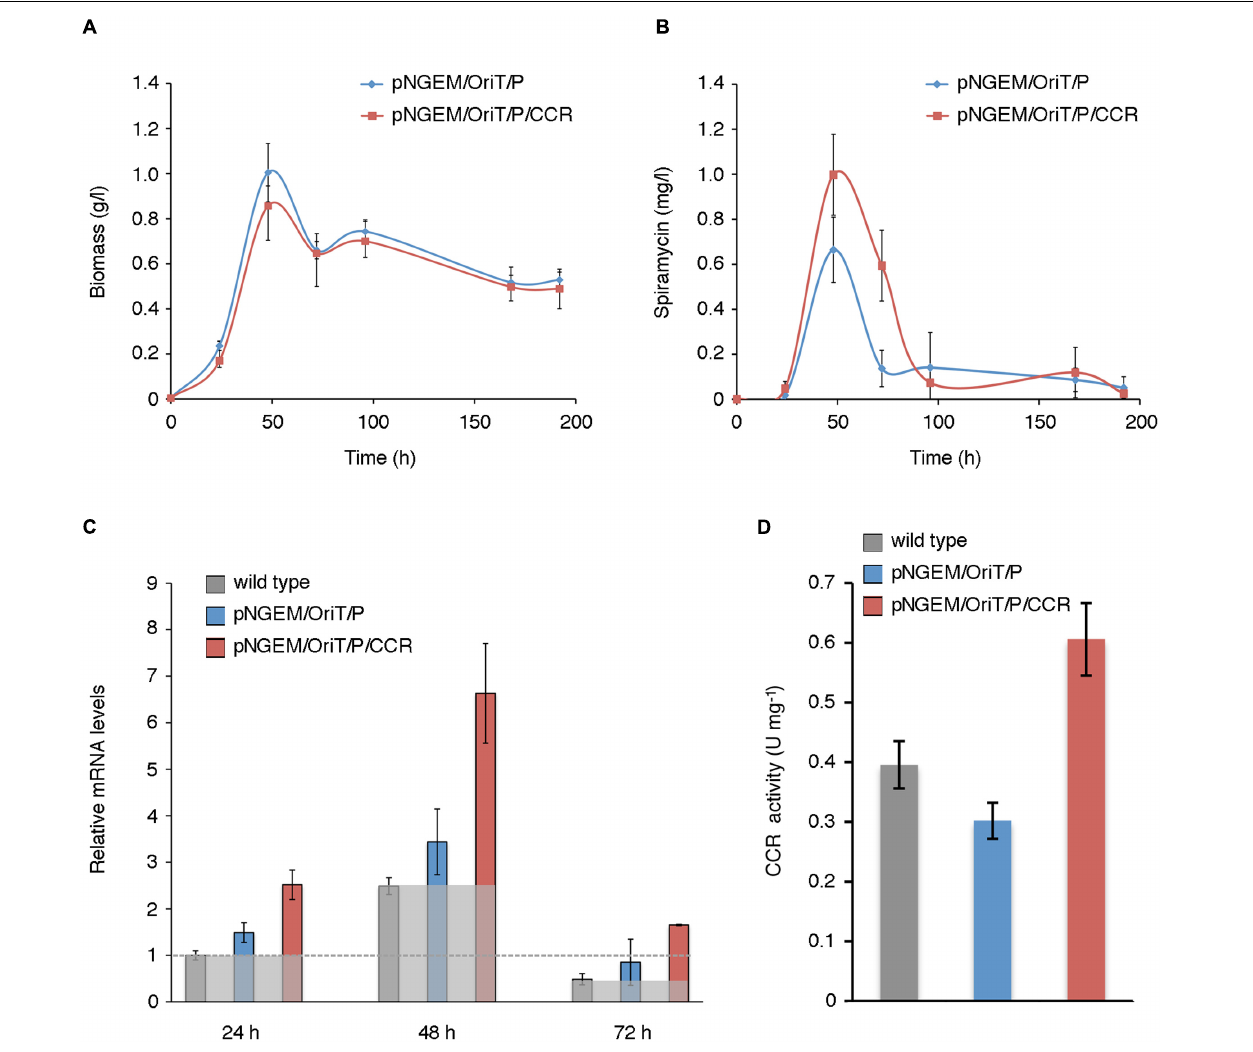
FIGURE 5 | Genetic manipulation of the ethylmalonyl-CoA metabolic node. (A,B) Mycelial growth (A) , and spiramycin production (B) of wild type and trans-conjugant strains harboring pNGEM/OriT/P/CCR or control plasmid pNGEM/OriT/P grown in YS medium. Values represent mean ± standard deviation (SD) (bars) from seven independent experiments (biological replicates). In (B) , each assay was carried out with triplicate samples (technical replicates). The variability associated with the technical replicates (including extraction and analytic procedure with samples processed the same day) was less than 0.3%. (C,D) ccr ( srm4 ) mRNA levels (C) and CCR enzymatic activity (D) in wild type and recombinant strains. In (C) , the expression levels of ccr ( srm4 ) (means from three independent experiments), compared with those of the wild type strain at 24 h arbitrarily assumed equal to 1, are reported. Bars represent standard deviations. The sheer gray boxes delineate the expression levels of ccr ( srm4 ) in the wild type strain for each time point; the gray dotted line marks the expression levels of ccr ( srm4 ) of the wild type strain at 24 h taken as calibrator for the histogram representation. In (D) the CCR enzymatic activity was determined in crude mycelial extracts of wild type and trans -conjugant strains harboring pNGEM/OriT/P/CCR or control plasmid pNGEM/OriT/P grown in YS medium for 48 h. Values represent means from three independent experiments. Bars represent standard